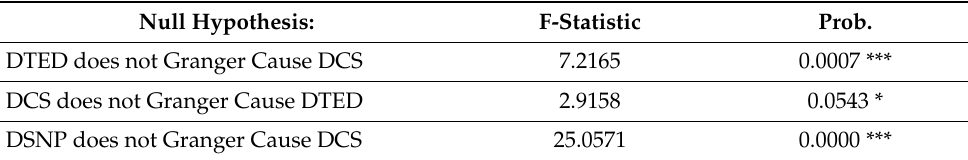
Table 13. Correlation after Orthogonalization. Table 14. Granger